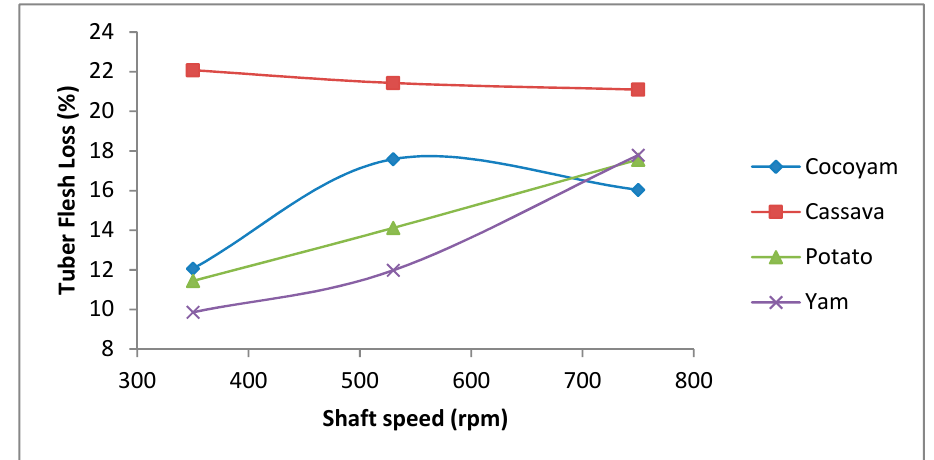
Figure 11. Effect of shaft speed on the flesh loss efficiency.